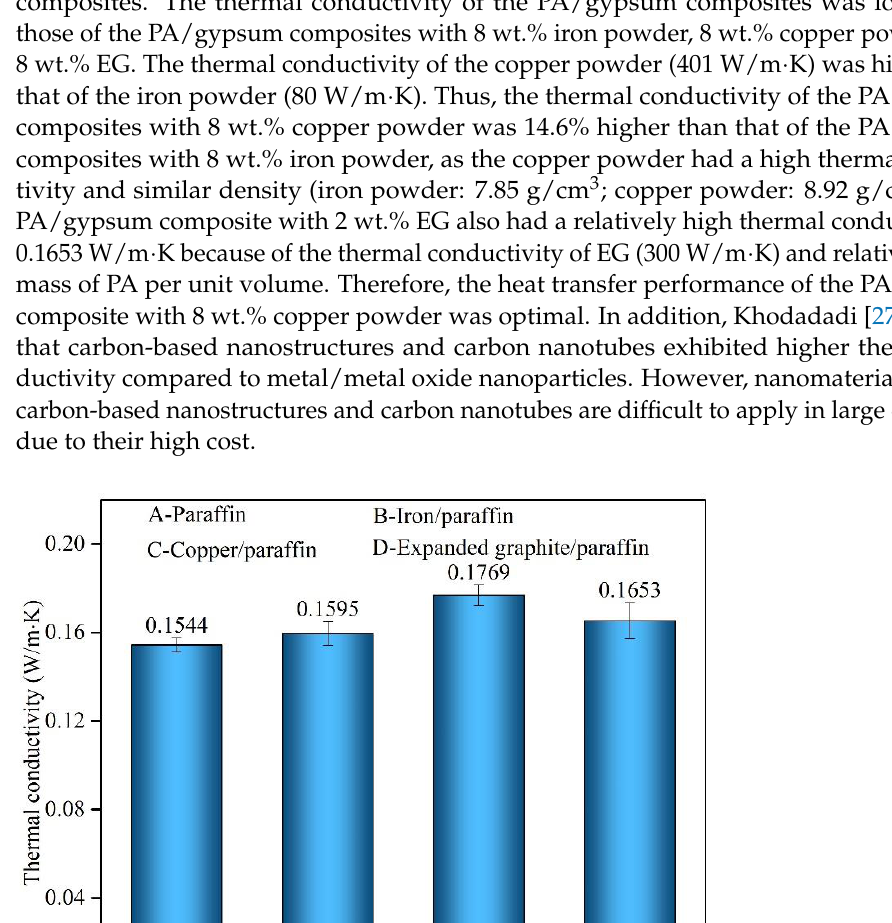
uted in a disordered manner according to the enlarged image in Figure 5a.